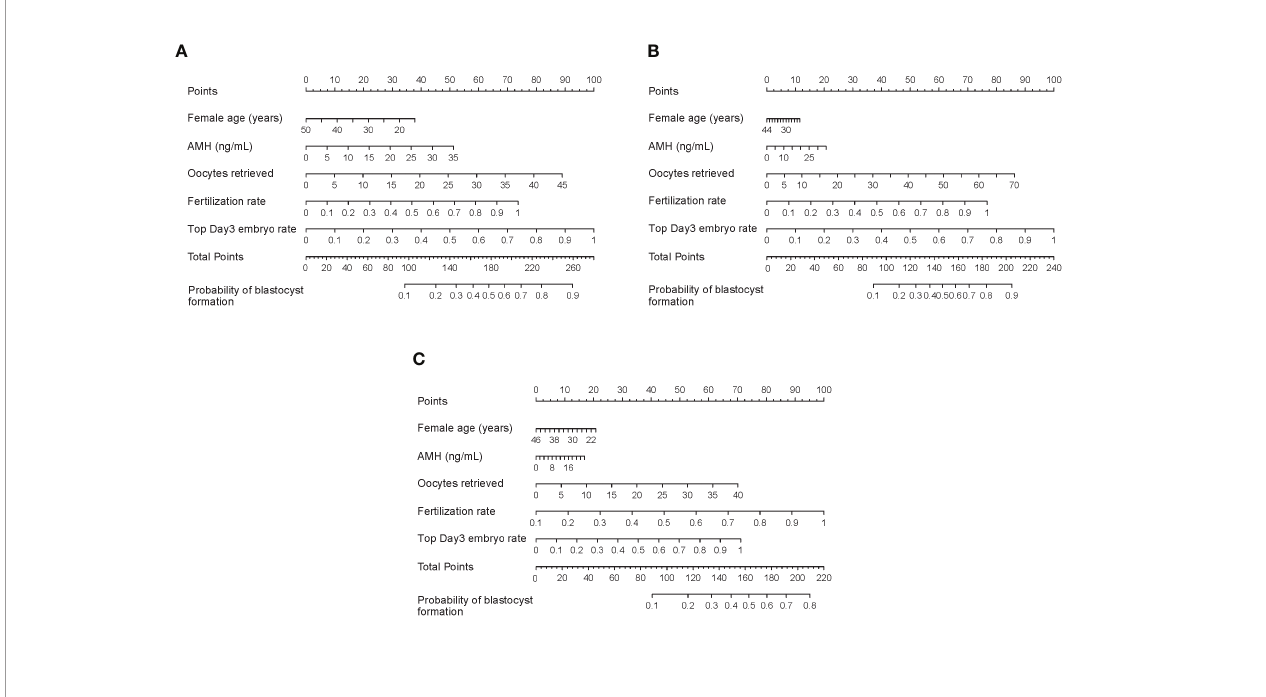
FIGURE 3 | Nomograms to predict blastulation rate after IVF cycle in patients with tubal factor infertility (A) , PCOS (B) , or endometriosis (C) . To read the nomograms, the predicted score for each variable is based on the upper points ruler. The total points were calculated by adding the point of each variable, and the individual probability of blastocyst formation is obtained by a vertical line projected from the total points line to the bottom line. PCOS, polycystic ovary syndrome; AMH, anti-Mullerian hormone; IVF, in vitro fertilization.